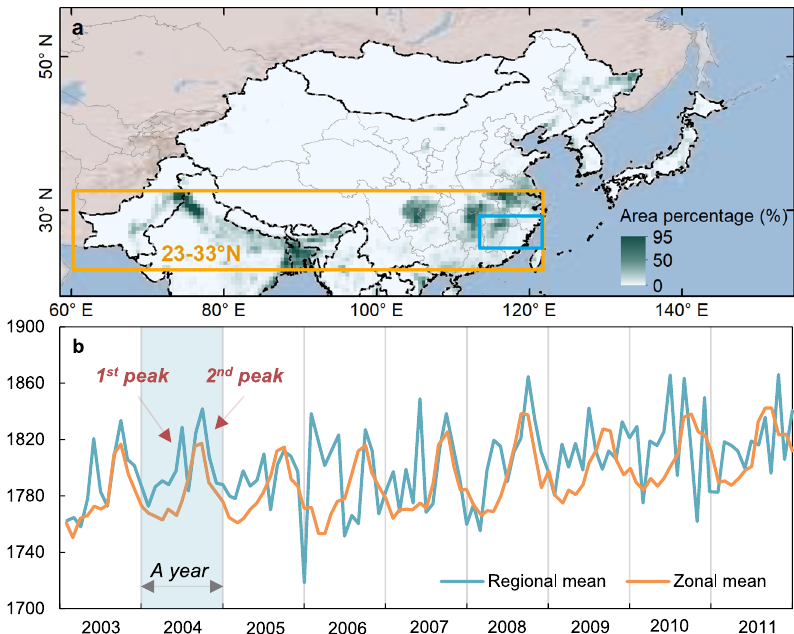
Fig. 2 Monthly averaged XCH 4 in the region of interest (ROI) of Southeast China and the latitudinal zone centered on the ROI according to Zeng et al. 2 . a The MODIS-based paddy rice map at 0.5° resolution in monsoon Asia in 2010. The orange rectangle shows the latitudinal zone of 23° – 33° N centered on the Southeast China ROI. The blue rectangle shows the boundary of the Southeast China ROI from Zeng et al. 2 . b Monthly averaged XCH 4 in the ROI and the latitudinal zone according to Zeng et al. 2 . The regional mean in b is the averaged value of XCH 4 in ROI, and the zonal mean in b is the averaged XCH 4 over the latitudinal zone centered on the ROI, which is from Zeng et al. ’ s paper 2